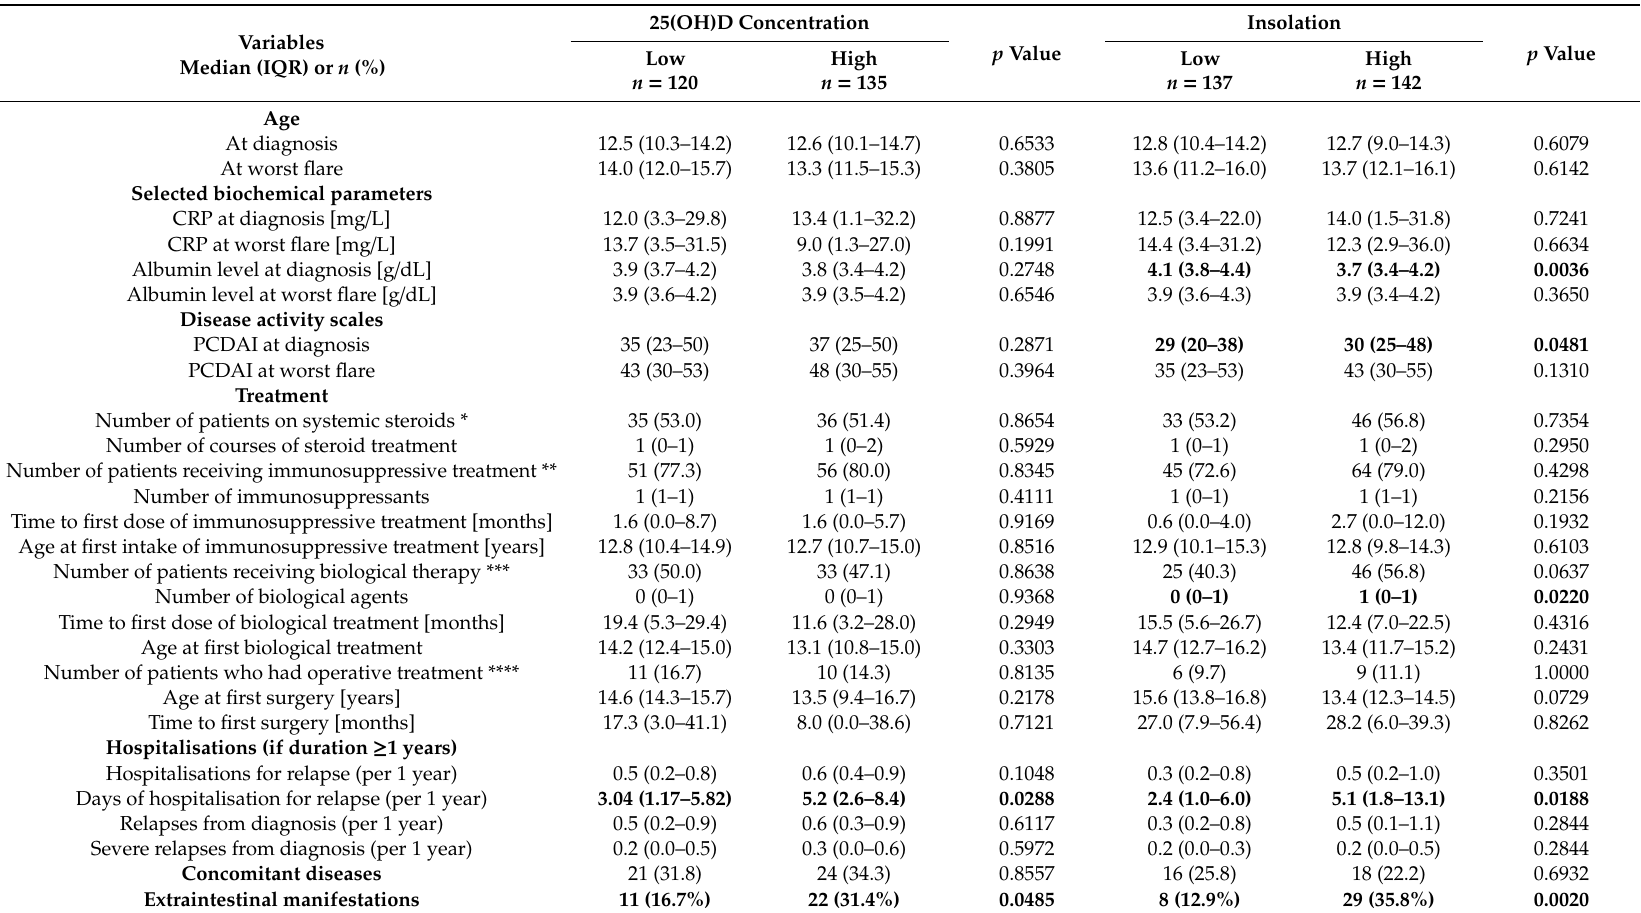
Table 3. Clinical characteristics of patients with Crohn’s disease in periods with typically highest and lowest vitamin D status and